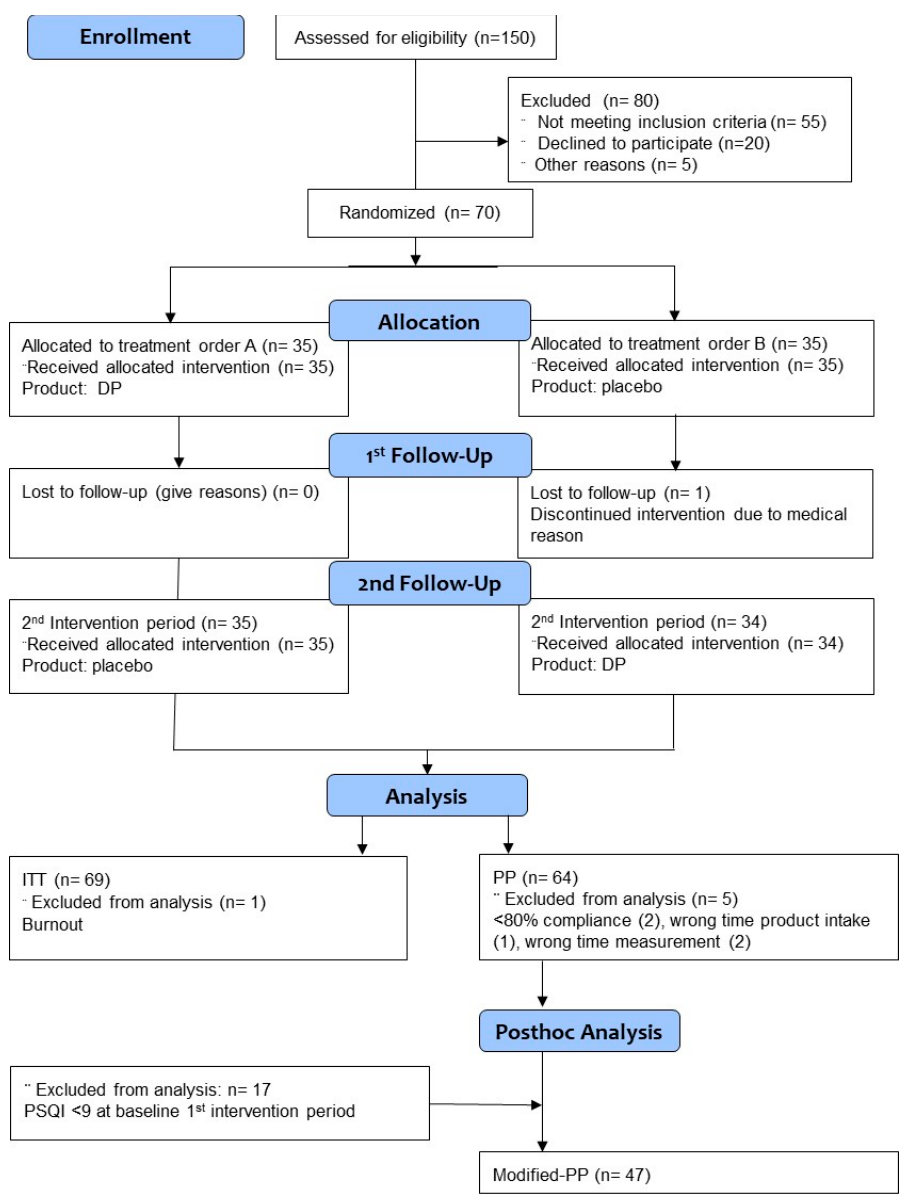
Figure 1. The recruitment–allocation–analysis flow diagram. DP, based on CONSORT 2010 but adapted for cross-over design: dairy-based test product; PSQI: Pittsburgh Sleep Quality Index. Table 2. General characteristics of study participants at the start of the study for the ITT, PP, and modPP study groups.